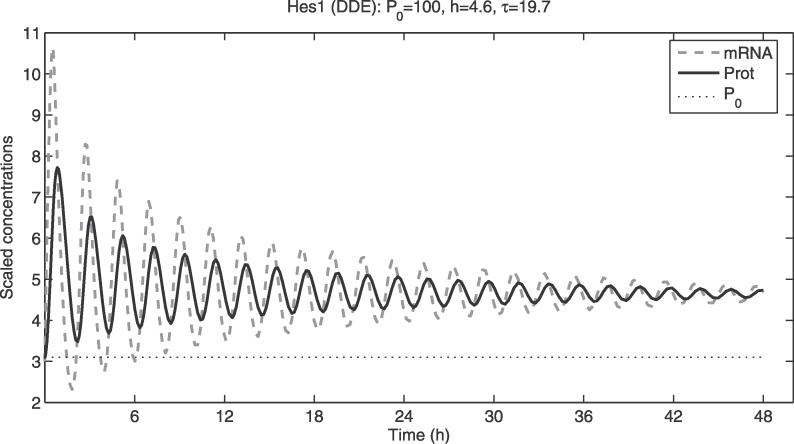
DDE Solution: Exploring the Effect of Large P
0